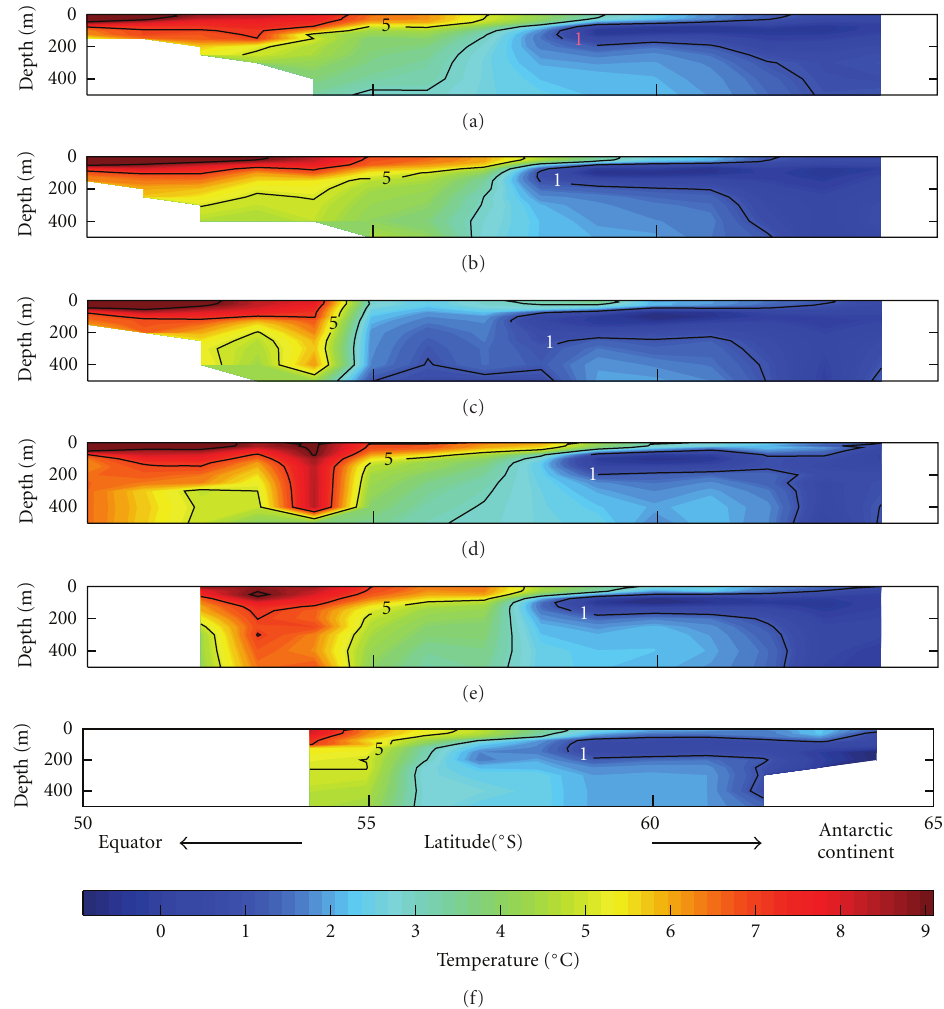
Figure 5: Vertical sections of the 5-year mean sea water temperature for the region 50 ◦ –65 ◦ S and 59–65 ◦ W during austral summer